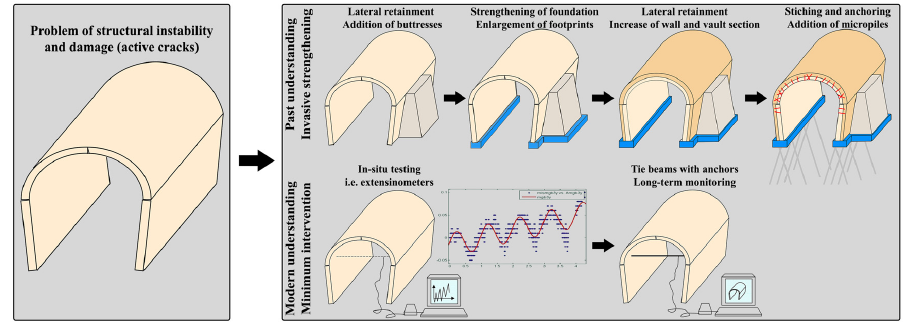
Figure1. Conservation and intervention. Blind confidence in modern and invasive techniques, with loss in authenticity and mistrust on the original capacity of the ancient structure vs. the modern understanding, combining minimum interventions and long‐term